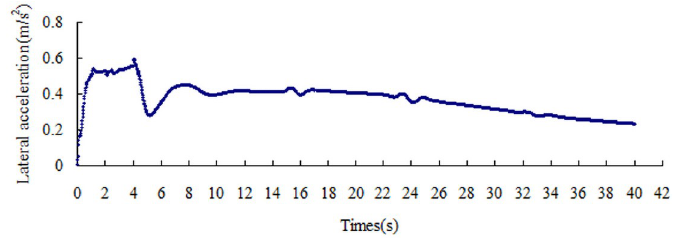
Fig 14. Lateral acceleration change graph of friction coefficient 0.7.